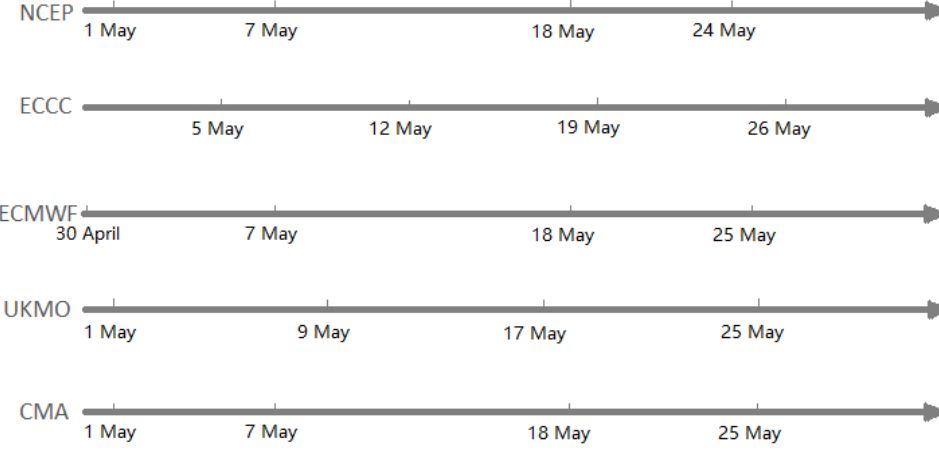
Figure 1. Start dates of the five models used in May .